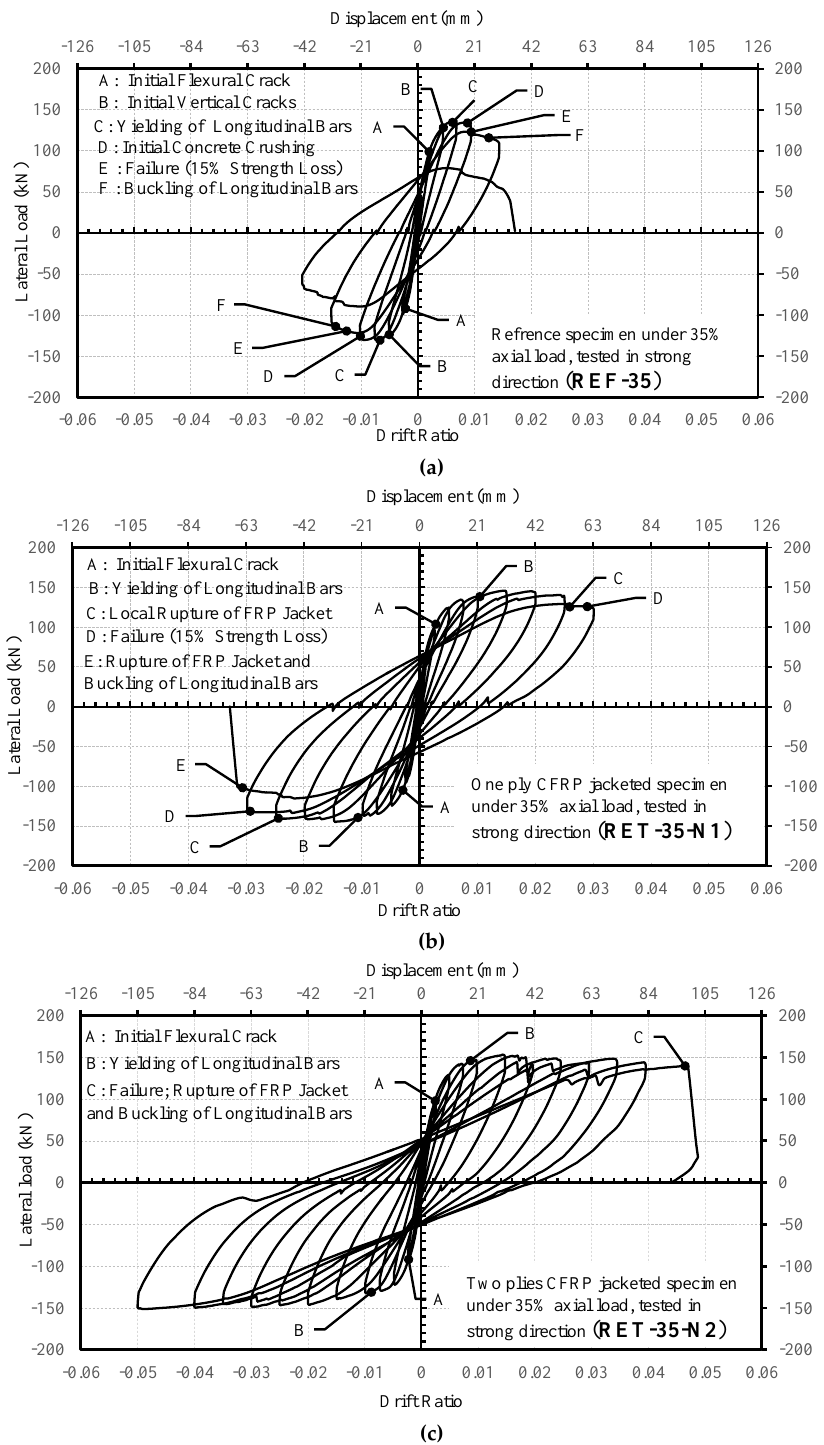
Figure 6. Lateral load-drift ratio relationships for the R35 series: ( a ) REF-35, ( b ) RET-35-N1; and ( c ) RET-35-N2.